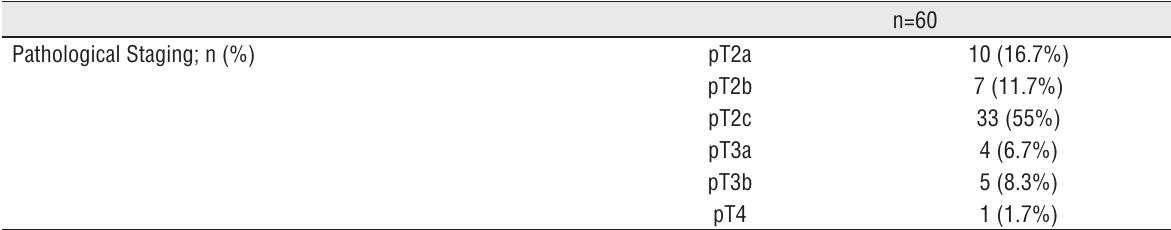
Table 2 - postoperative pathological